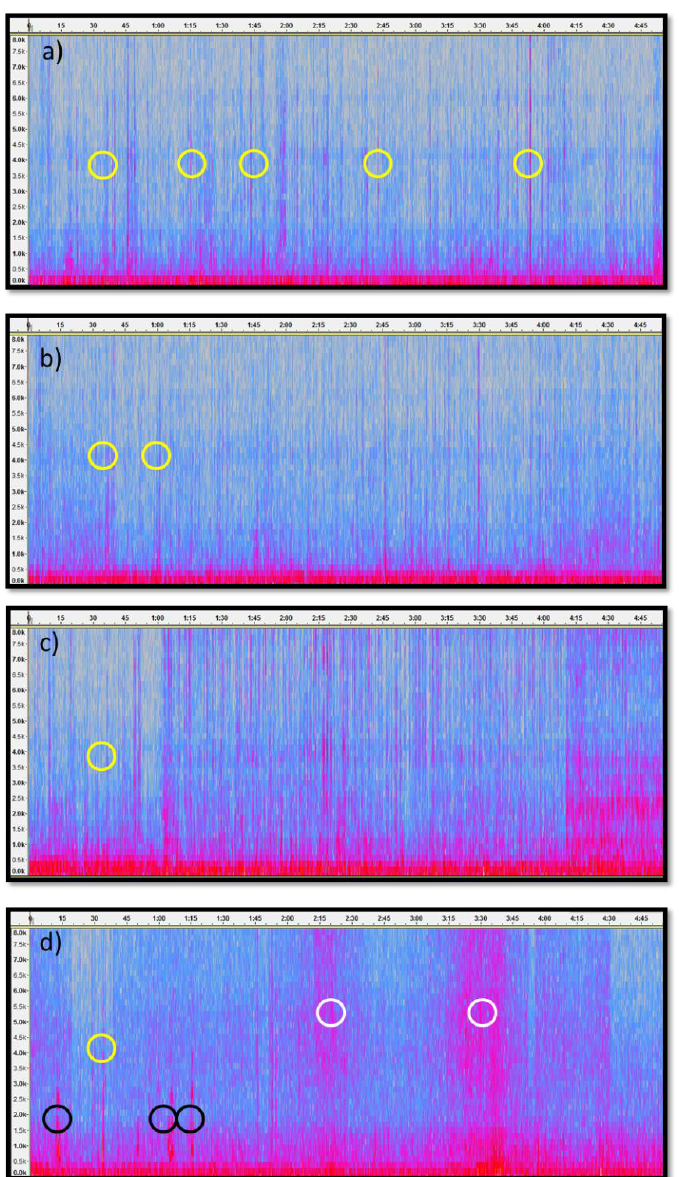
Figure 7. Example of time-frequency spectrograms of the sound levels in VH1: ( a ) Monday; ( b ) Tuesday; ( c ) Wednesday; ( d ) Thursday. Yellow circles identify examples of sounds of cutlery and kitchenware while lunch was being served to residents by staff members. White circles identify a cleaning machine; black circles identify a vocalizing, agitated resident during lunch.